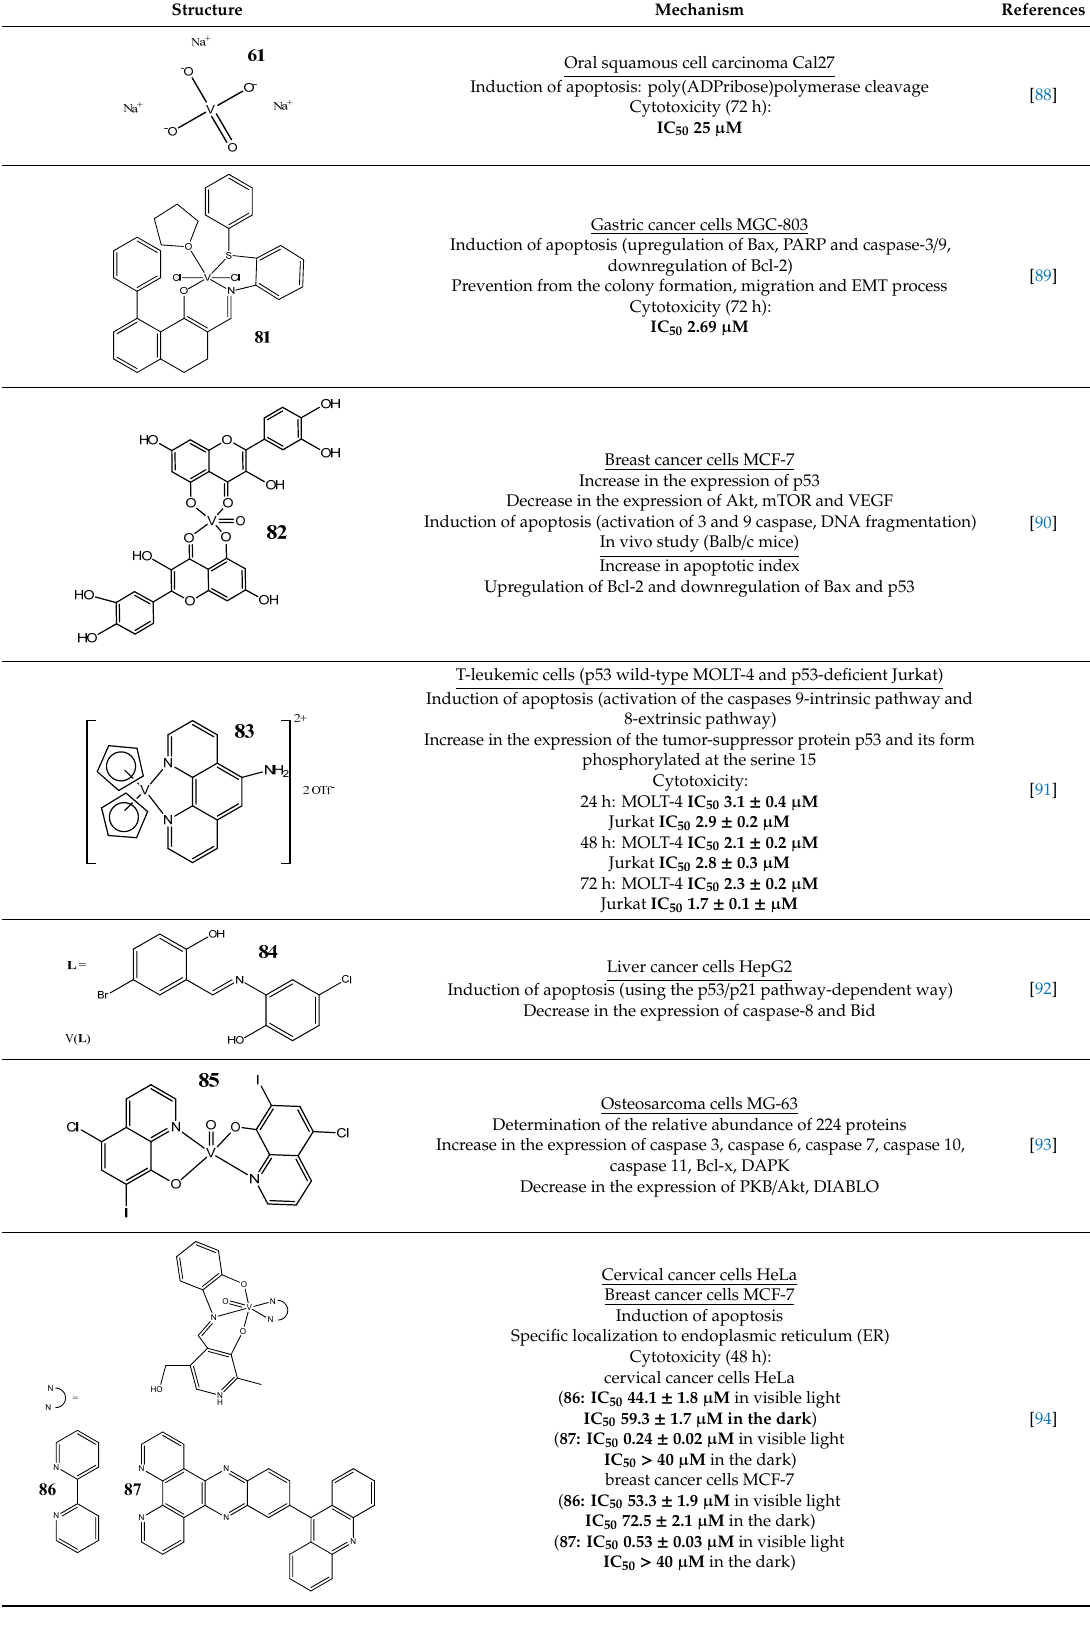
Breast cancer cells MDA-MB-231 G 2 /M cell cycle arrest Induction of autophagy Induction of apoptosis Increase in the expression of Notch 1 [101] 91 MSAGM:VO MSAGM = Galactomannan from Schizolobium amazonicum Liver cancer cells HepG2 Induction of apoptosis under normoxic conditions (lost under hypoxic conditions) The expressions of anti-apoptotic Mcl-1 and Bcl-XL increased in hypoxia, whereas the expression of pro-apoptotic Bax decreased Induction of autophagy (elimination of the anti-cancer activity with activation of autophagy under conditions of hypoxia) [102] Bold and underline: makes table more readable. Summary of the described molecular and cellular mechanisms of vanadium compounds are illustrated in Figure 2.